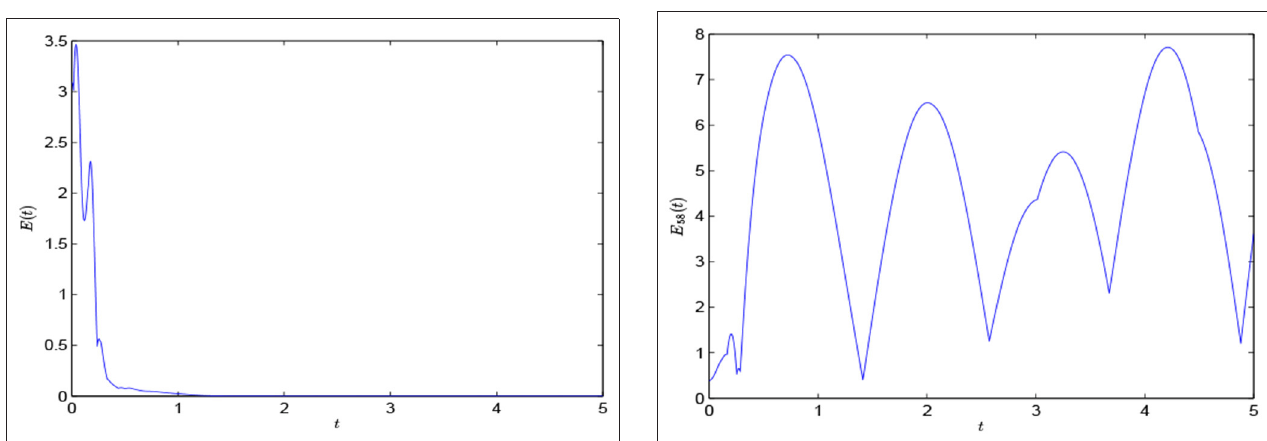
FIGURE 3 | The time evolution of E ( t ). FIGURE 4 | The time evolution of E 58 ( t